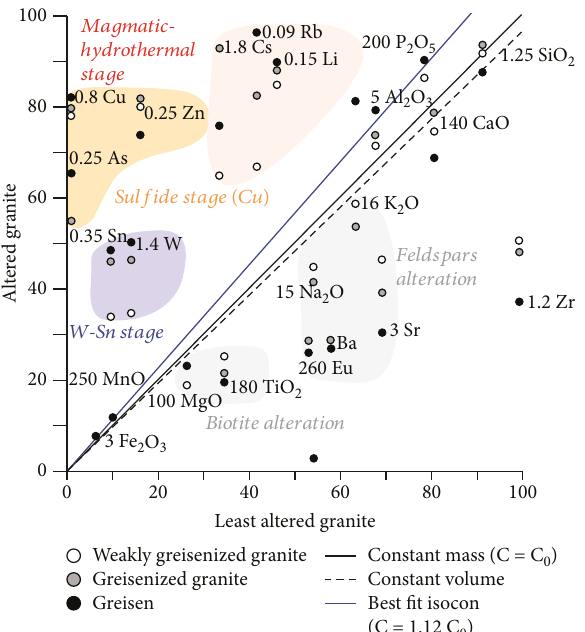
Figure 7: Isocon diagram comparing the chemical composition of the least altered granite and the Panasqueira greisen. Granite composition is an average of 5 analyses. Oxide analyses are in wt% and trace elements in ppm; values are scaled with the factors indicated for each element. The best fi t isocon (blue line) de fi ned from P O , Al O , MnO, and Fe O is compatible with an 2 5 2 3 2 3 immobile alumina during the greisen alteration. This best fi t is characterized by a slope of 1.12 corresponding to a volume decrease of about 12.4%. For comparison, an isocon based on hypotheses of constant mass (black line) and constant volume (dashed line) is also